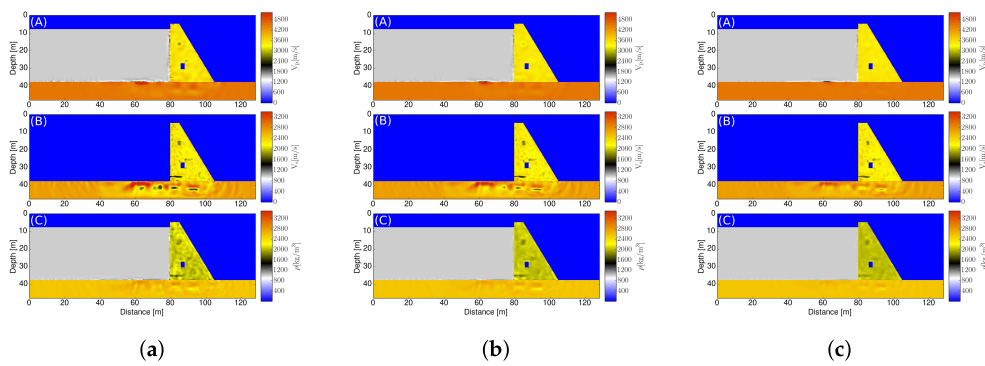
Figure 12. FWI results for anomaly identification, ( a ) 1% noise ( b ) 5% noise ( c ) 10%